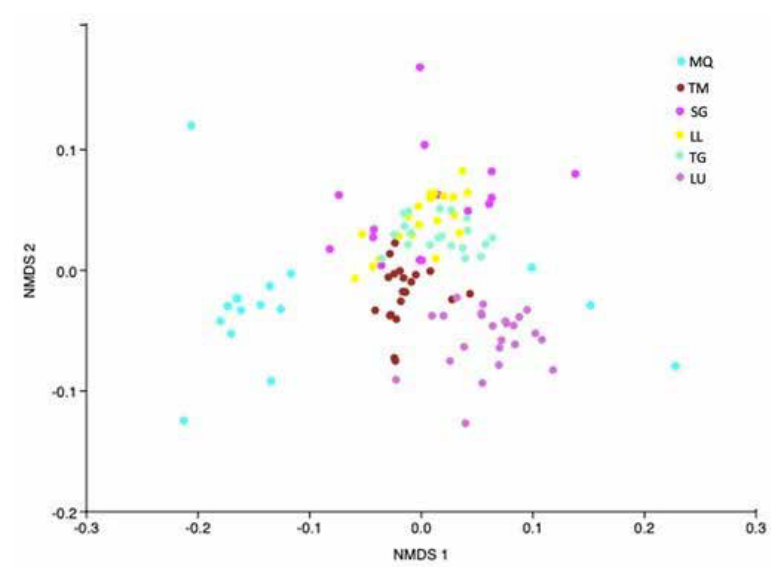
Fig. 5: Non-metric multidimensional scaling (NMDS) based on Bray-Curtis distance. Ordination plot illustrating differences in macroinvertebrate abundance between wetlands